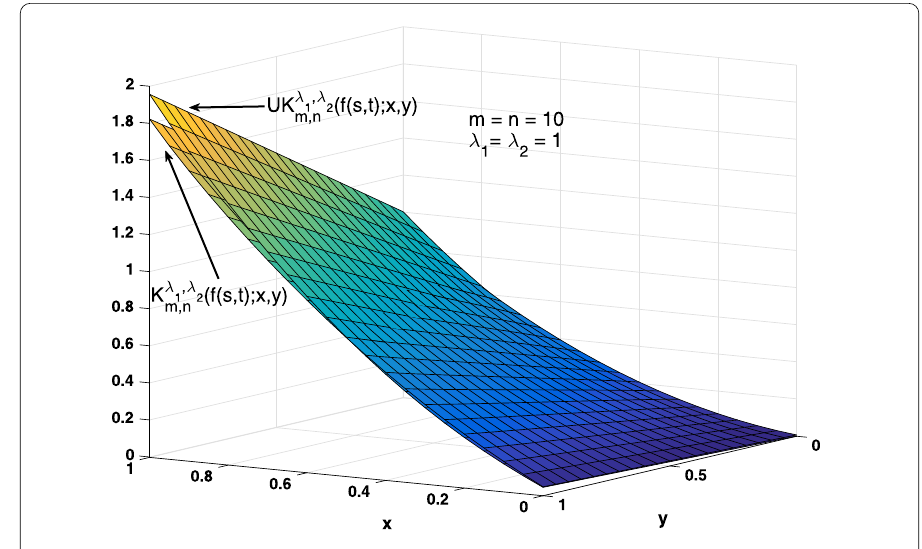
Figure 4 Graphs of K 1,1 10,10 ( f ; x , y ) and UK 1,1 10,10 ( f ( s , t ); x , y